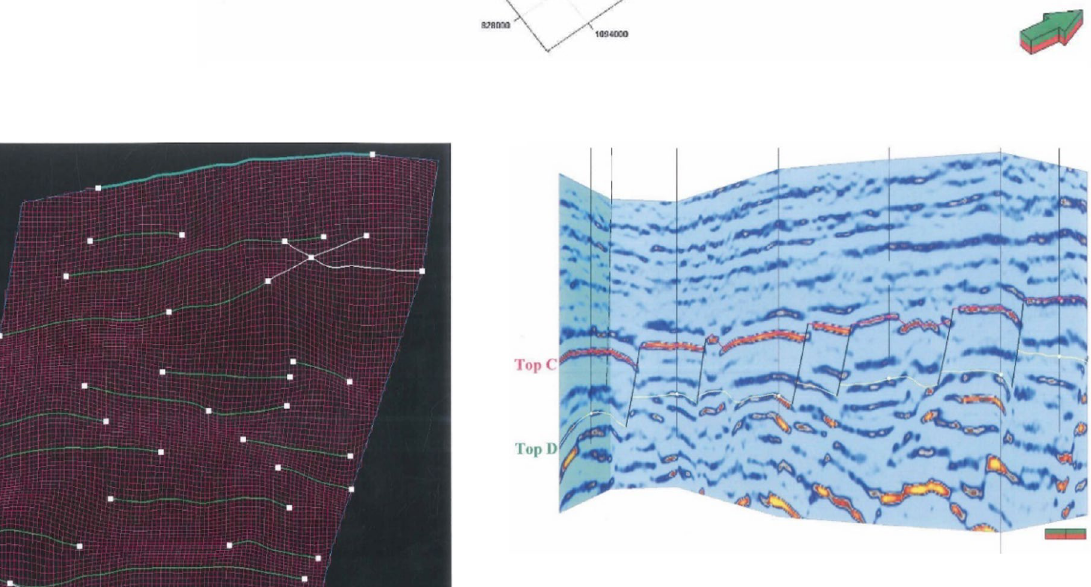
Fig. 11 Comparison between facies and stratigraphy model to seismic